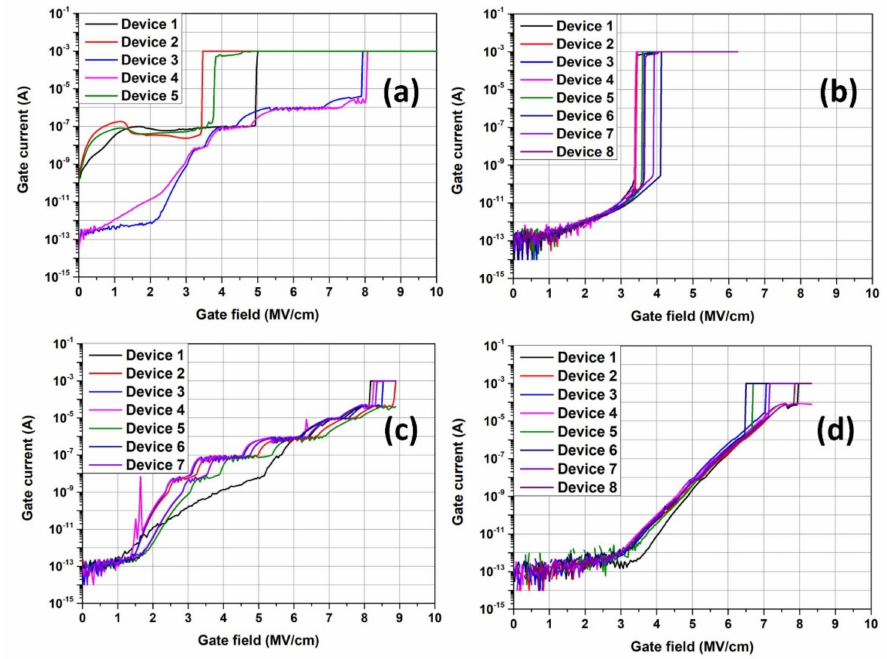
Figure 8. Dielectric breakdown curve of gate oxides fabricated by ( a ) 60 min 1300 ◦ C O 2 dry oxidation, ( b ) 15 min 1300 ◦ C O 2 wet oxidation, ( c ) 120 min 1300 ◦ C N 2 O dry oxidation and ( d ) 30 min 1300 ◦ C O 2 dry oxidation + 90 min 1300 ◦ C N 2 O